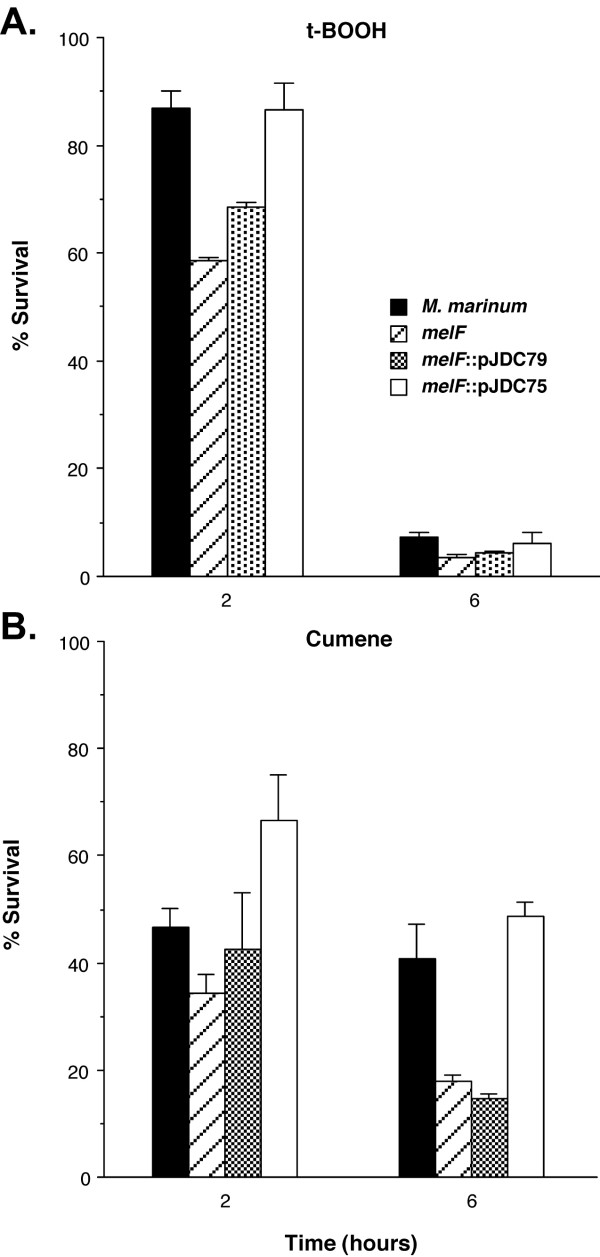
Susceptibility of the mel2 mutant to reactive oxygen species. Susceptibility of M. marinum wild type as compared to the mel2 mutant that carries an insertion in melF (melF), the mutant carrying a plasmid expressing melF alone (melF::pJDC79) and an integrated single copy plasmid expressing the entire mel2 locus (melF::pJDC75) to 10 mM tert-butyl hydroperoxide (t-BOOH, A) or 100 mM cumene hydroperoxide (Cumene, B). The % survival = (CFU Tx/CFU initial) × 100. Data are the means and standard deviations of assays done in triplicate, representative of three experiments.